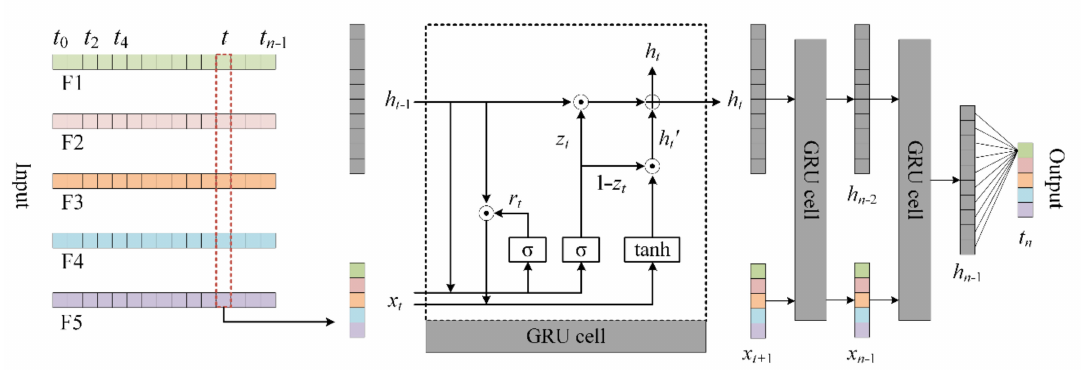
Figure 6. The structure of a single gated recurrent unit (GRU)